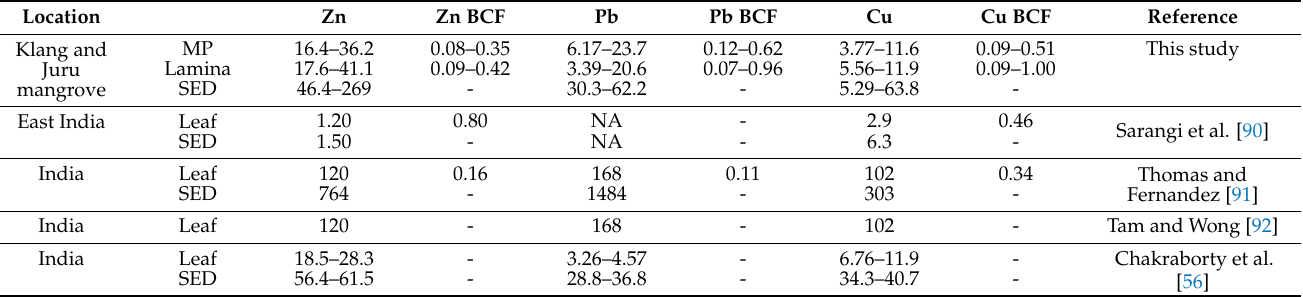
Table 14. Comparison of concentrations (mg/kg dry weight) of Zn, Pb, and Cu in the leaves of Avicennia officinalis and their bioconcentration factor (BCF)